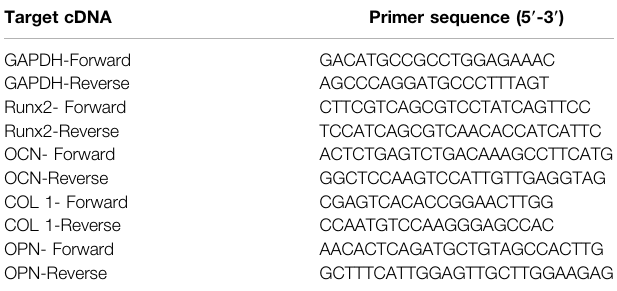
TABLE 1 | List of qRT-PCR